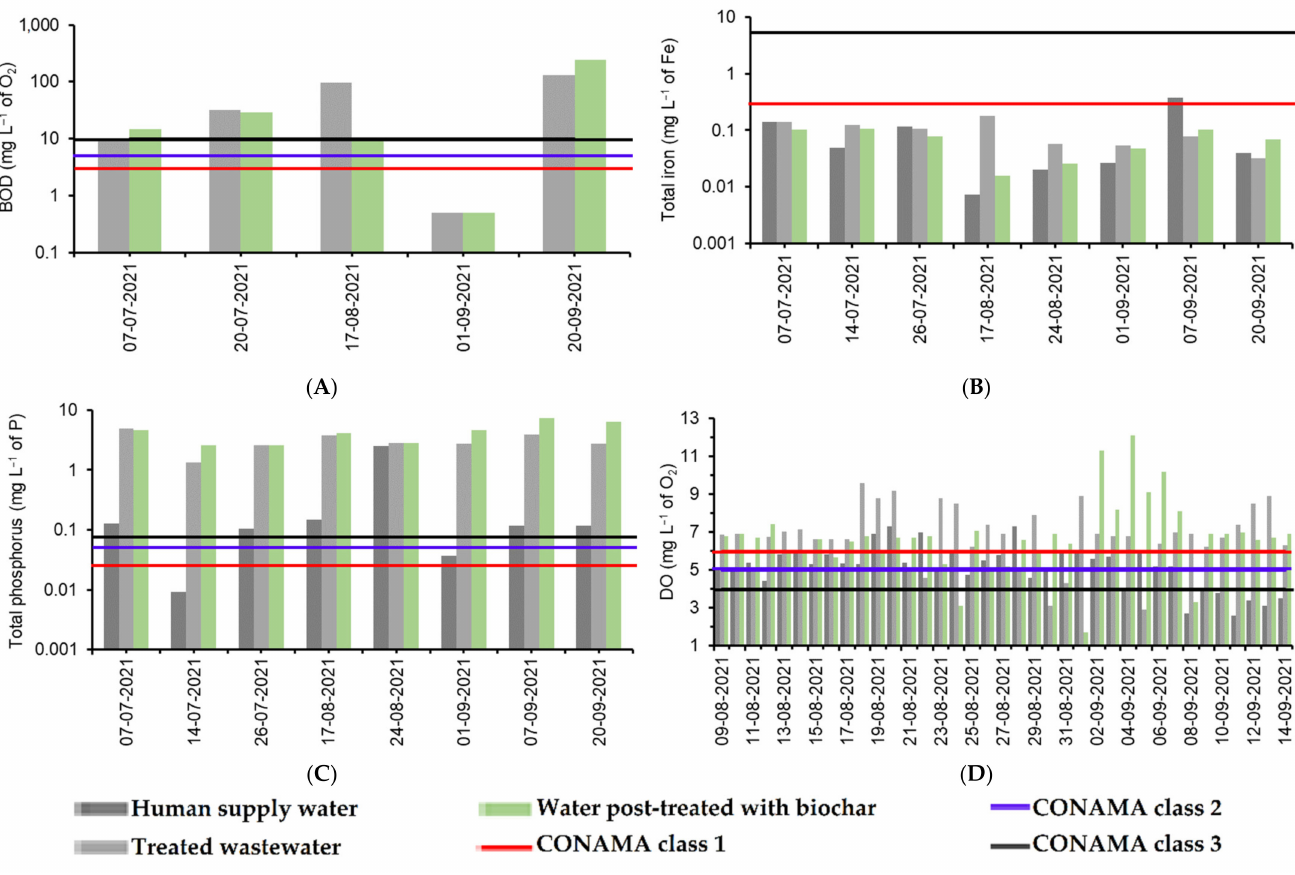
Figure 3. Physicochemical parameters of water sources: ( A ) biochemical oxygen demand (BOD); ( B ) total iron; ( C ) total phosphorus; ( D ) dissolved oxygen